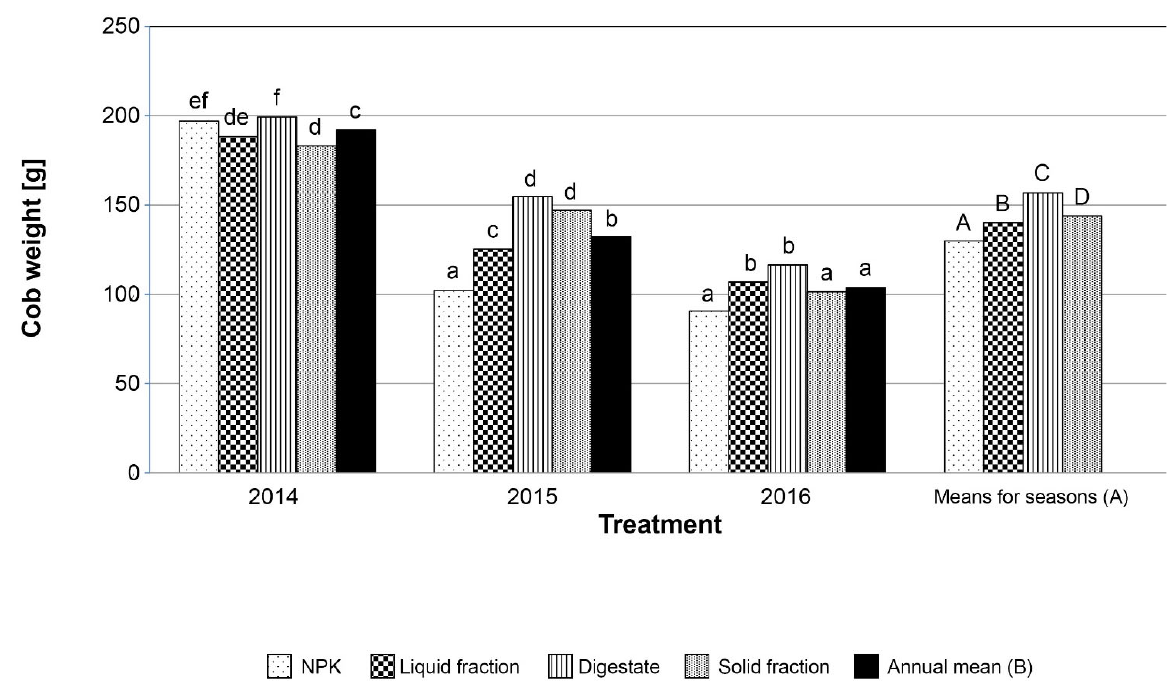
Figure 4. Weight of maize cobs in respective growing seasons and experimental treatments. Legends: No letter means no significant differences. The same lowercase letter means no significant differences among mean values for a treatment within the same season and for interaction of season × treatment. The same capital letter means no significant differences among the treatments.